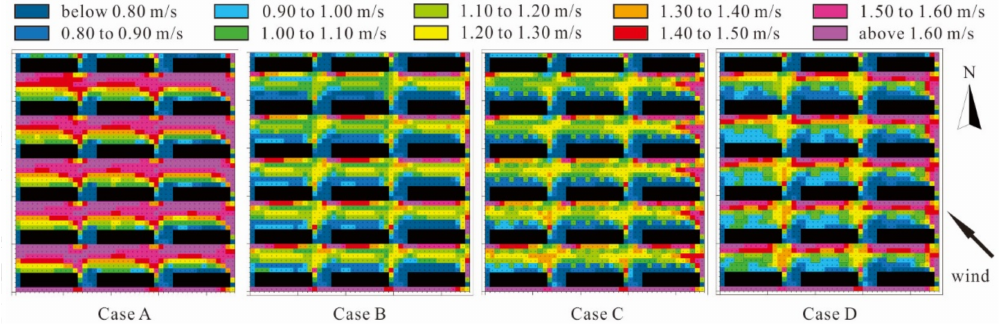
Figure 11. Contours of wind speed distribution in the residential district at pedestrian height on 23 June at